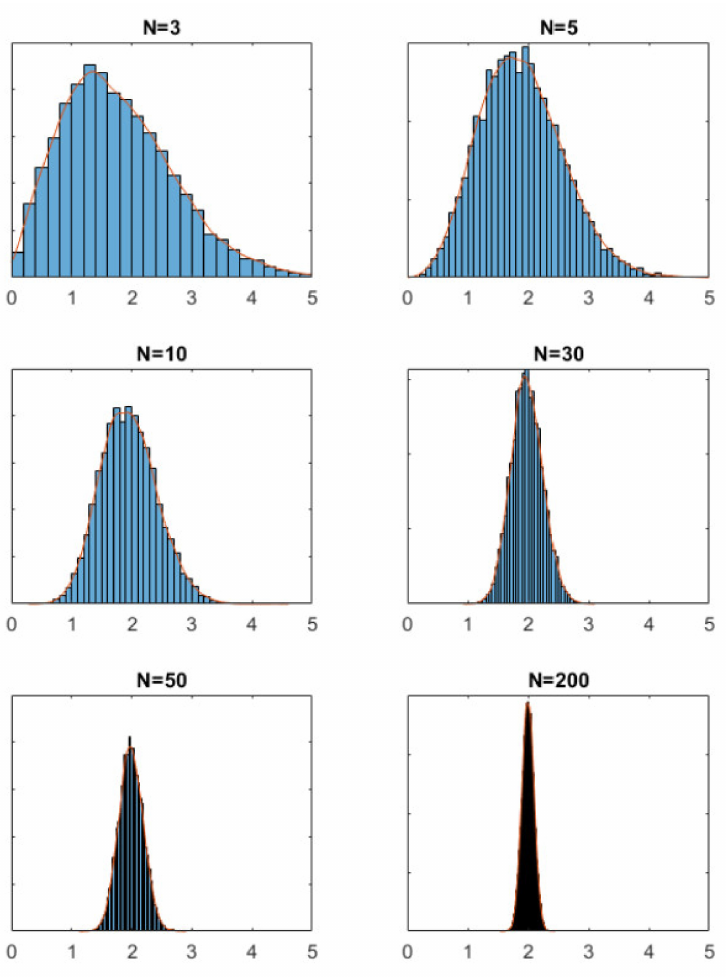
Figure A5. Distribution of the samples' standard